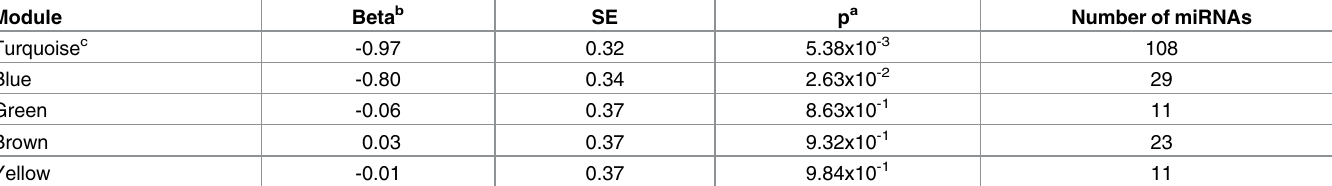
SE, standard error; p, p-value a p-values represent association of the module eigengenes, the first principal component of expression levels of a module, with case status. b Beta values are in log expression level units.